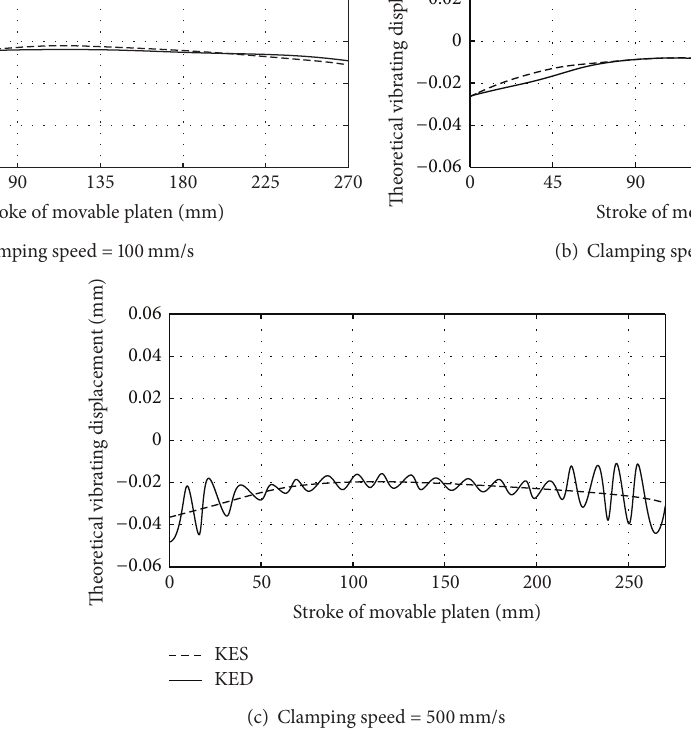
Figure 11: Vibrating displacement of K point in 𝑌 direction at different clamping